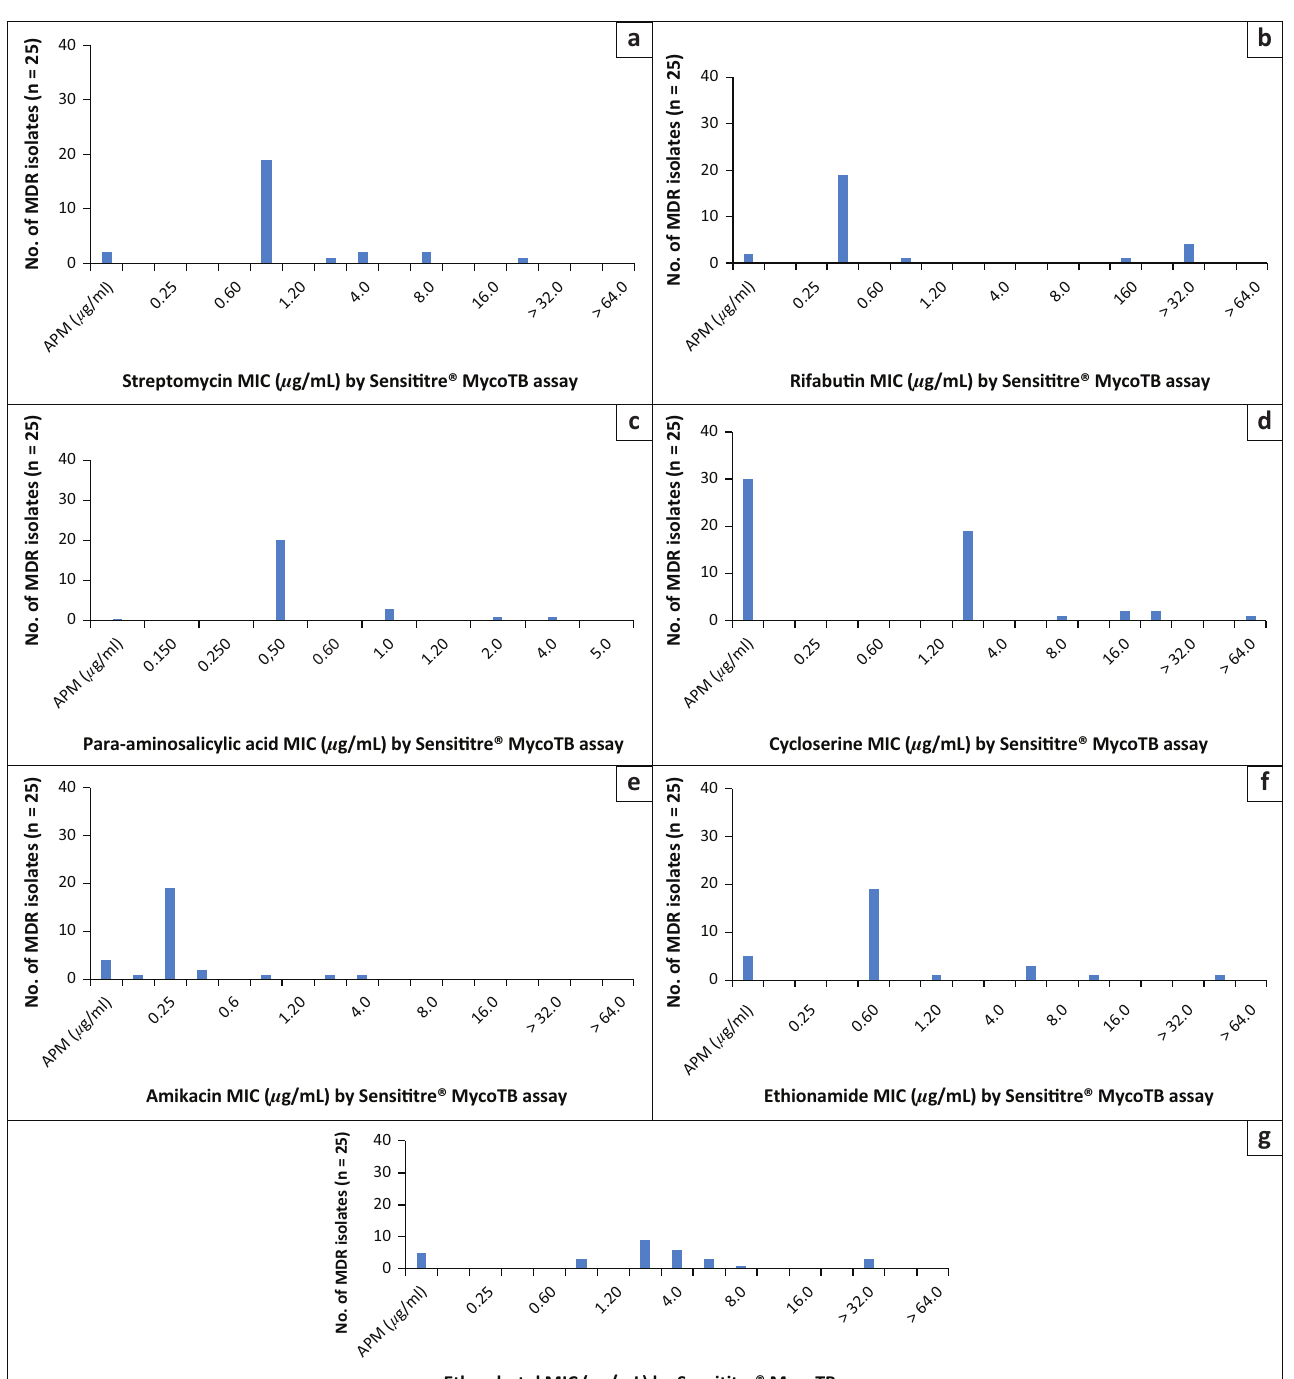
APM, agar proportion method; MIC, minimum inhibitory concentrations; ETH, ethionamide; EMB, ethambutol; AMI, amikacin; STR, streptomycin; PAS, para-aminosalicylic acid; RFB, rifabutin; CYC, cycloserine; No., number. FIGURE 5: Distribution of minimum inhibitory concentrations ( µ g/mL) for additional first- and second-line antibiotics using the Sensititre plate method for clinical multidrug-resistant tuberculosis isolates. (a) STR (25 isolates), (b) RFB (25 isolates), (c) PAS (25 isolates), (d) CYC (25 isolates), (e) AMI (25 isolates), (f) ETH (25 isolates) and (g) EMB (25 isolates), Inkosi Albert Luthuli Central Hospital, Durban, South Africa, January 2014 – June